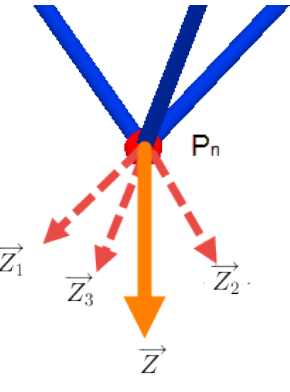
Figure 20. Component of Z with respect to the parallel segments.